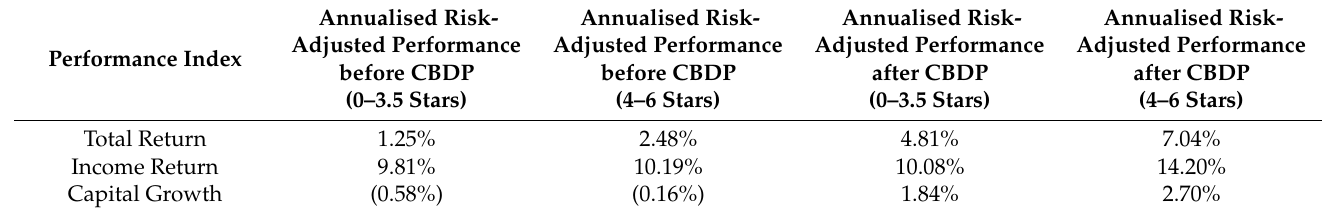
Table 4. Non-CBD market—risk-adjusted performance non-green (0–3.5 stars) vs. green (4–6